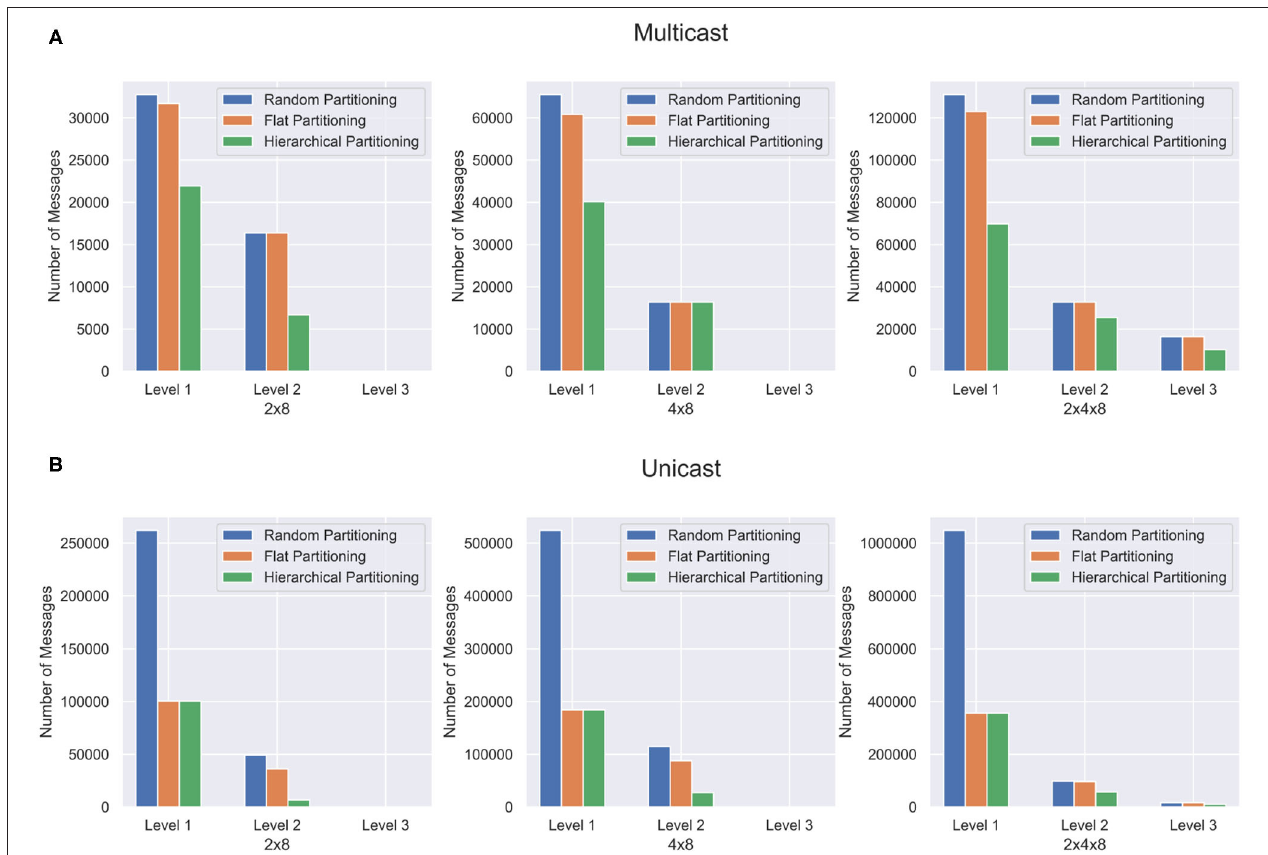
FIGURE 7 | Partitioning results for the deep feedforward network. The network is partitioned in three different ways and communication cost reduction is demonstrated using (A) multicast and (B)